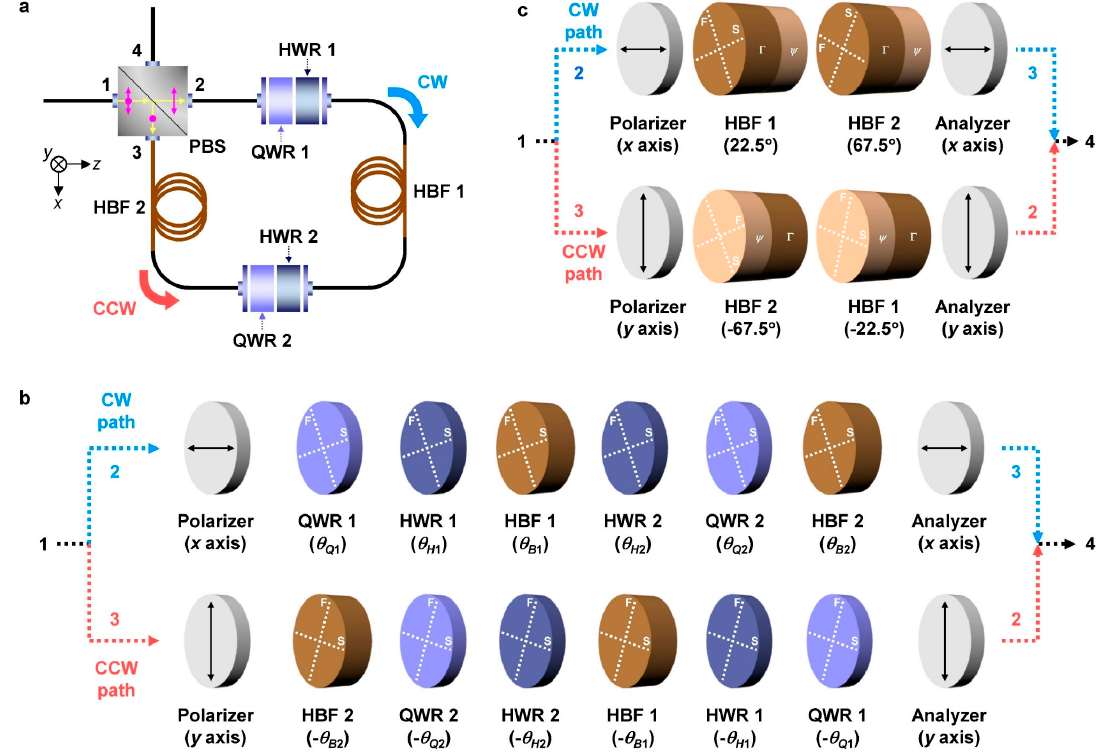
Figure 1. ( a ) Schematic diagram of the proposed filter, ( b ) propagation paths of light circulating within the filter, and ( c ) equivalent arrangement of high birefringence fiber (HBF) segments for continuous wavelength tuning of narrowband comb spectrum.